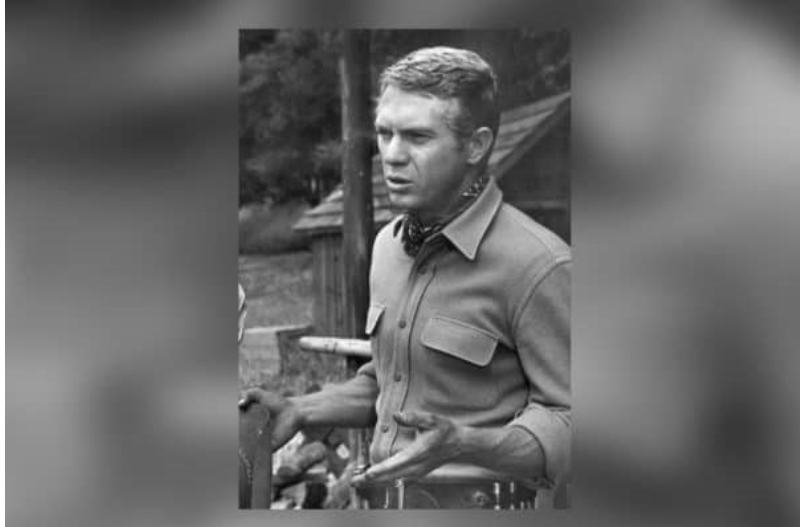
Figure 2. The well-known American actor, Steve McQueen, died of mesothelioma in 1980 at the age of 50. McQueen’s first exposure to asbestos likely occurred during his service in the U.S. Marine Corps from 1947 to 1950. Through his service, McQueen spent time working onboard naval ships and in the shipyards.